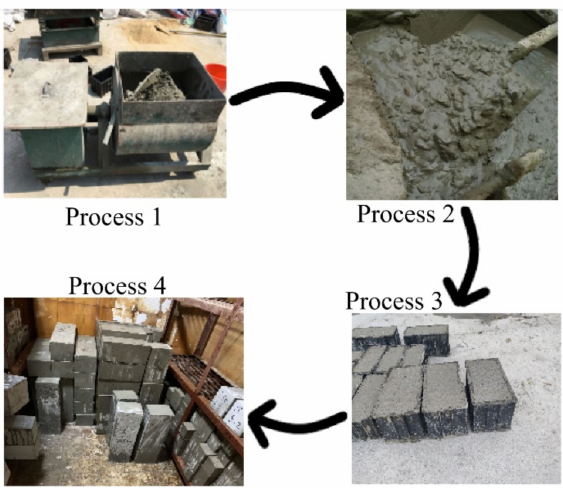
Figure 4. The mixing and curing process of